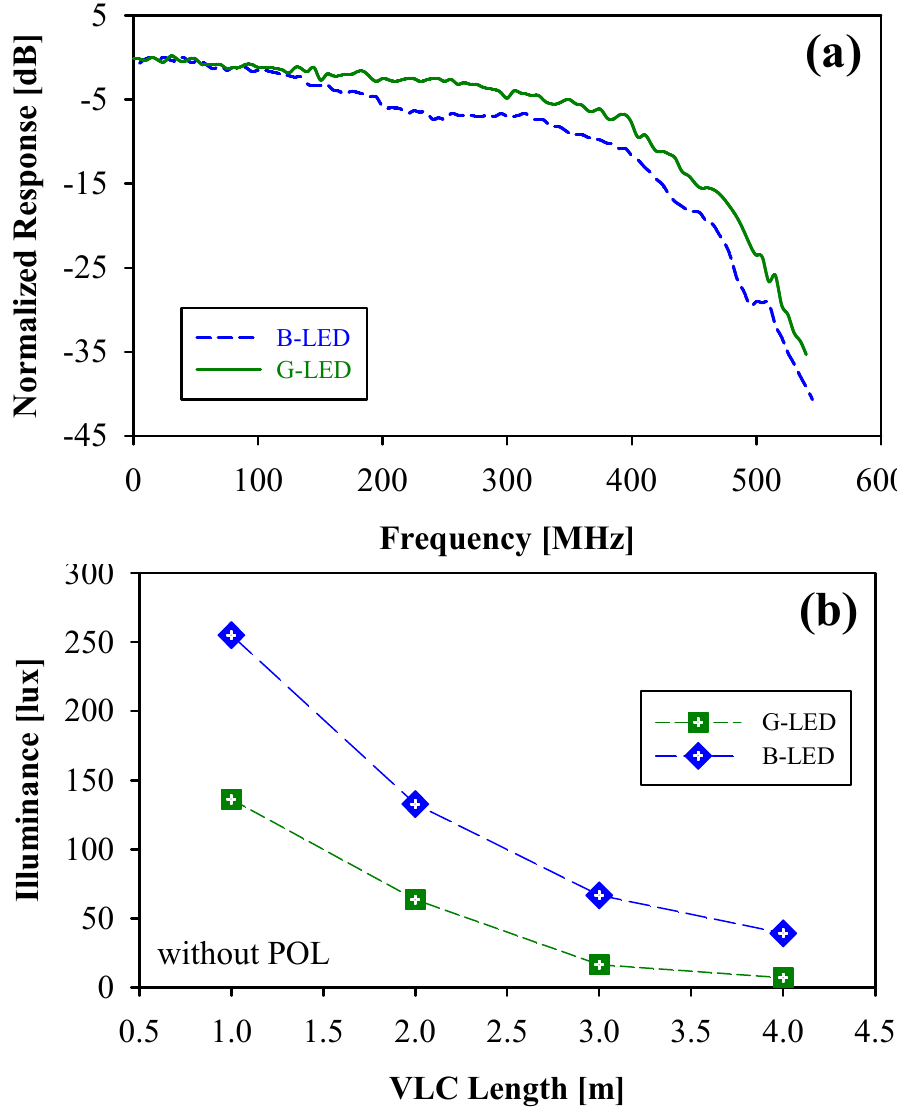
Figure 2. ( a ) Measured achievable bandwidths of the G − and B − LEDs. ( b ) Detected corresponding illuminances of the G − and B − LEDs without using POL versus various VLC lengths before launching into the focusing lens.